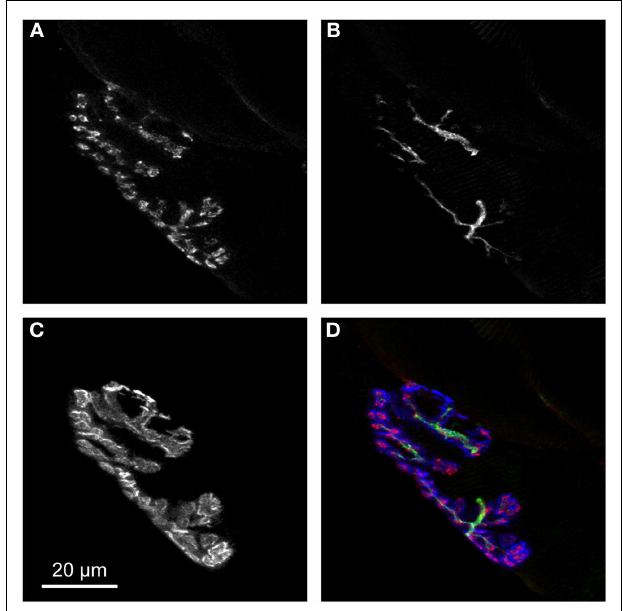
FIGURE 1 | Pre- and post-synapse exhibit perfect complementarity in young adult NMJs . (A,B) Pre-synaptic terminal as represented by motoneuronal markers for synaptic vesicles [synaptophysin (A) ] and neuronal cytoskeleton [neurofilament (B) ]. (C) Post-synaptic apparatus contains large amounts of AChRs directly juxtaposed to pre-synaptic ACh filled synaptic vesicles. (D) Overlay of synaptophysin (red), neurofilament (green), and AChR stainings (blue) nicely shows the perfect complementarity of pre- and post-synaptic portions of